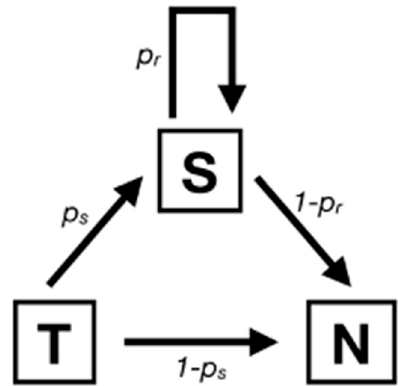
Figure 1. Markov model of polymerase stuttering. In this model, three states are possible: Transcribe, Stutter, Next. The two rates in the figure can be inferred from deep sequencing data.